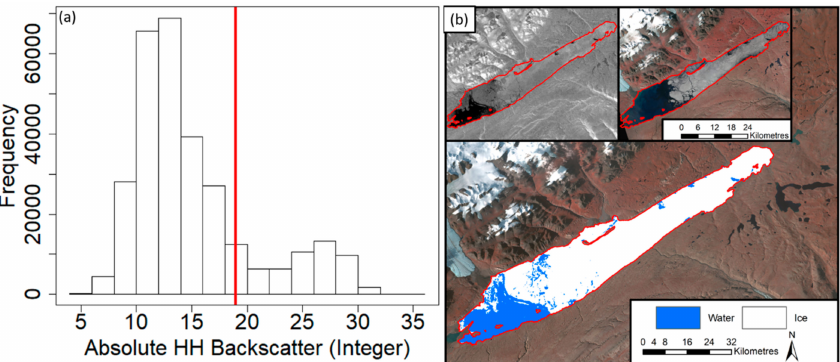
Figure 7. ( a ) shows the histogram for the Sentinel-1 image acquired on 31 July 2016 with the threshold of 19 represented by the solid red line, and ( b ) shows the image classified using the determined threshold value of 19. Landsat-8 Level-1 image courtesy of the U.S. Geological Survey (Digital Object Identifier (DOI) number: / 10.5066 / F71835S6); this figure also contains Copernicus Sentinel-1 data (2016), processed by